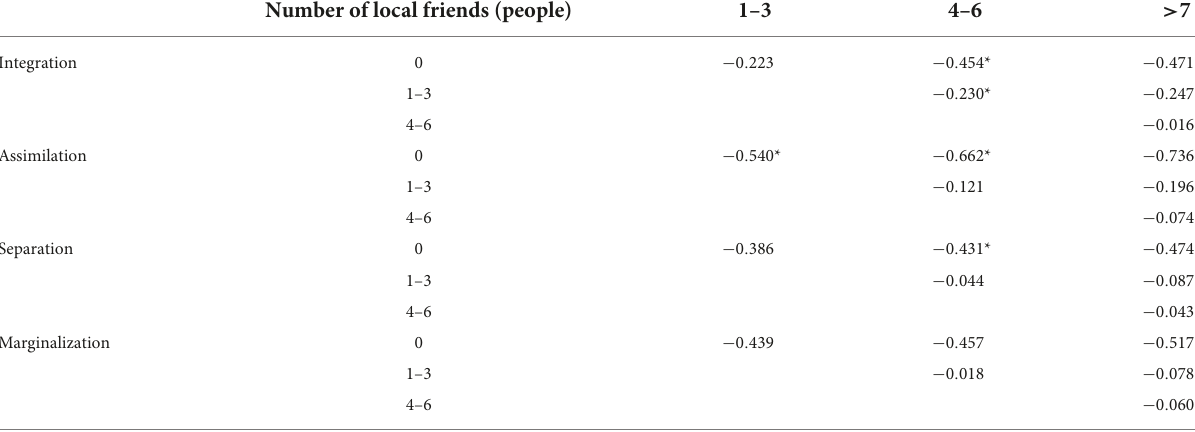
TABLE 6 Post hoc of the number of local friends on intercultural adaptation strategies. Number of local friends (people)